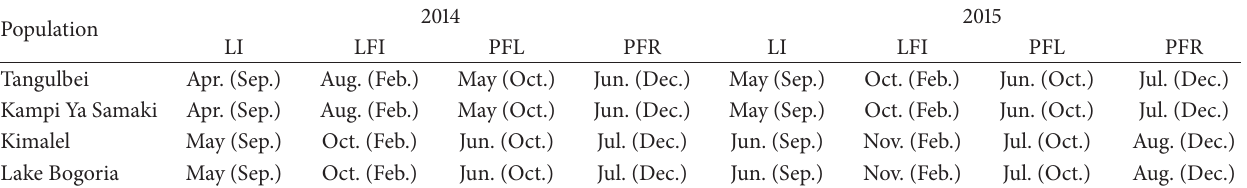
Table 1: Phenological events of S. senegal within Lake Baringo woodland ecosystem for years 2014 and 2015.